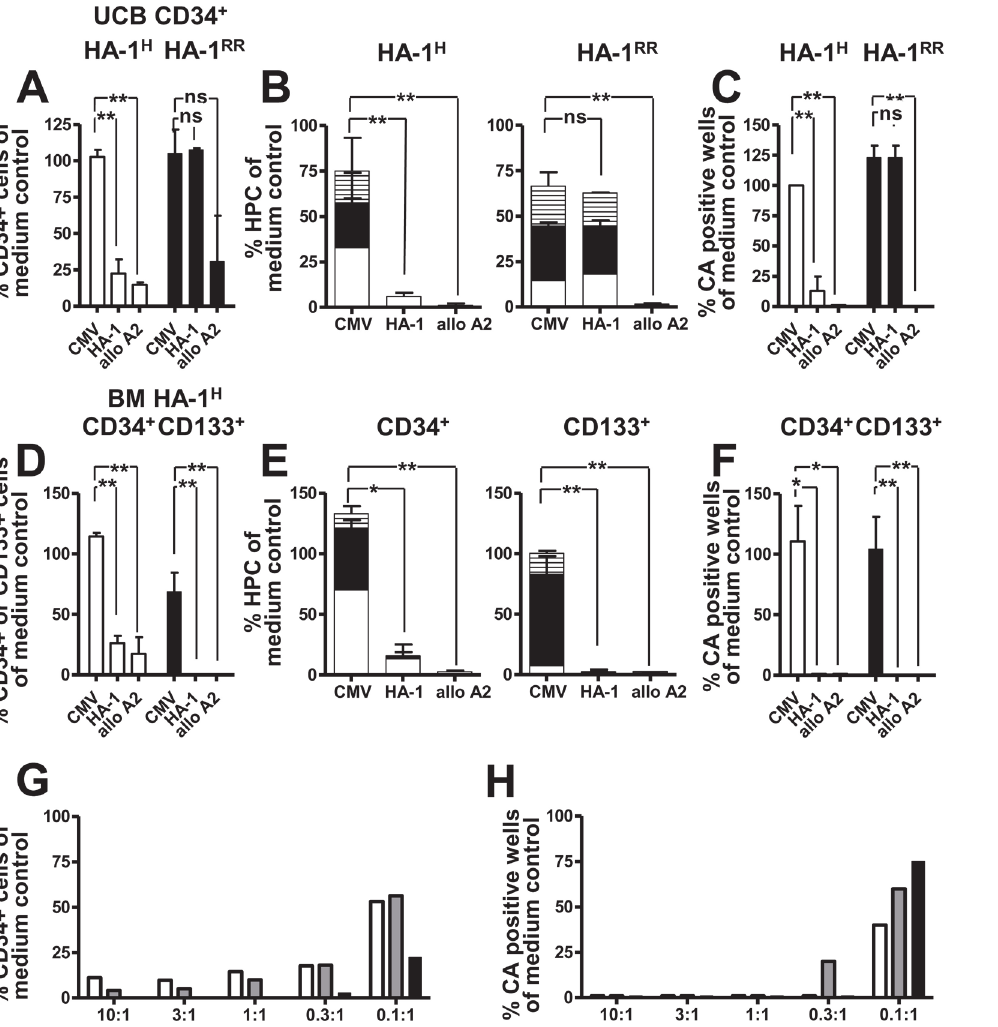
Fig 3. HA-1 H specific elimination of human umbilical cord blood and bone marrow derived hematopoietic progenitor/stem cells by HA-1 CTLs studied in vitro. (A-F) Umbilical cord blood (UCB) derived CD34+ and bone marrow (BM) derived CD34 + and CD133 + cells from HLA-A2/HA-1 H or HLA-A2/ HA-1 RR donors were incubated with medium, an irradiated control CMV CTL clone, an HA-1 CTL clone or an anti-HLA-A2 specific CTL clone overnight. Data are mean +/- Standard deviation of independent experiments with 3 HA-1 H and 2 HA-1 RR donors, respectively ( * p < 0,05; ** p < 0.01, ns = not significant using a two-tailed Student ’ s t-test). The results of the medium control were set as 100%. (A, D) % viable CD34 + or CD133 + cells (duplicate sample per donor) compared to the medium control directly after over-night co-incubation with CTLs. (B, E) % colony forming cells (single sample per donor) compared to the medium control as determined after 14 days; CFU-macrophage (CFU-M; striped bar), CFU-Granulocyte (CFU-G; black bar), blast forming unit (BFU-E; white bar). (C, F) % of cobblestone area positive wells (4 – 5 samples per donor) in a CAFC assay compared to the medium control as determined after 5 weeks. (G- H) An HA-1 CTL clone was titrated to BM derived CD34+ cells (white bars), UCB derived CD34+ cells (grey bars) and to BM derived CD133 + cells (black bars) from HLA-A2/HA-1 H donors and co-incubated over night. x-axis: HA-1 CTL to CD34 or CD133 cell ratio. Y-axis: % viable CD34 + or CD133+ cells (duplicate sample per donor) compared to the medium control (G) and % of cobblestone area positive wells in a CAFC assay (4 – 5 samples per donor) compared to the medium control as determined after 5 weeks